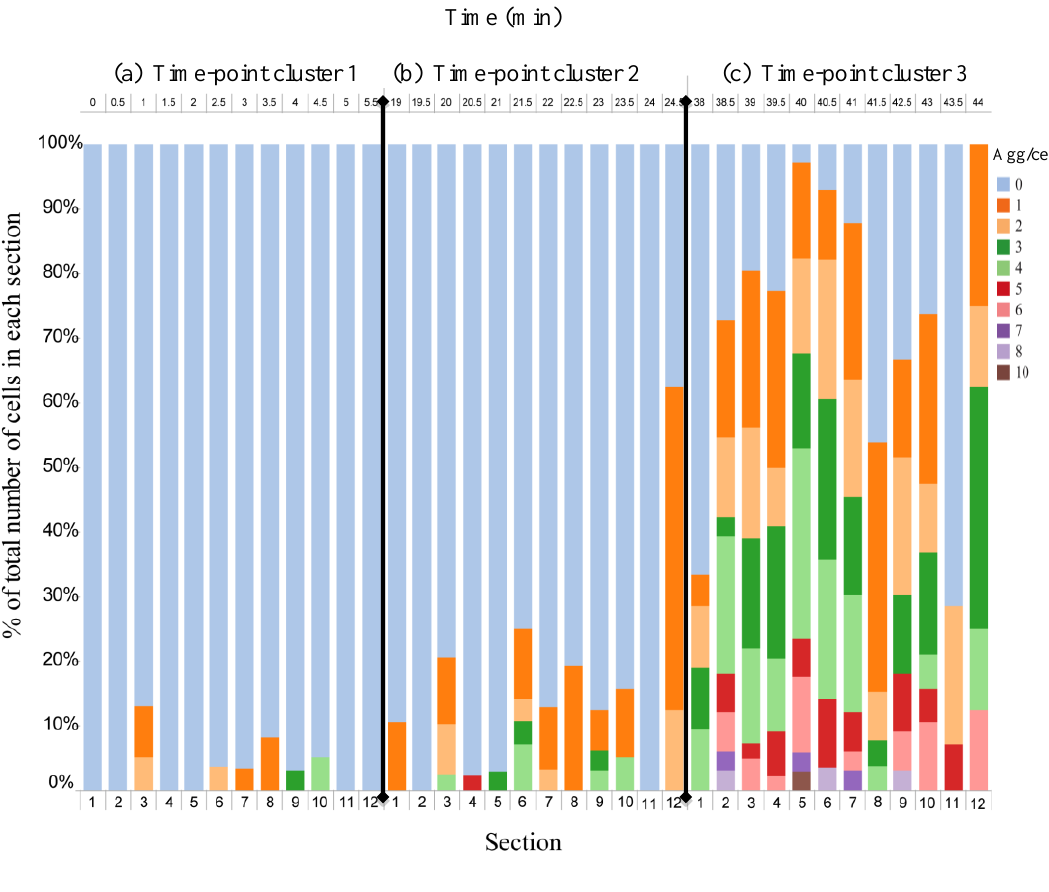
Figure 6. Single-cell responses to the arsenite stress under the 25 nL min −1 flow rate condition. Results represent the formation of Hsp 104-GFP aggregates in individual cells in three significant time-point clusters during the experiment. The time-point clusters ( a – c ) are separated by black solid lines. A clear increase in the number of aggregates under the influence of the treatment was observed in exposed cells. The color code designates the number of aggregates per cell. Color bars in the figure denote the percentage out of all trapped cells in each segment having a certain number of aggregates. For instance, in segment 3, cluster ( a ), around 8% of the cells have one, 5% have two and the rest show no aggregates. In cluster ( b ) these values increase to 10.3% of the cells with one, 8% with two, 2.6% with four and the rest with zero aggregates. Number of aggregates per cells in cluster ( c ) climbs up to 24.4% with one, 17% with two, 17% with three, 14.6% with four, 2.5% with five, 5% with six, and the rest with no